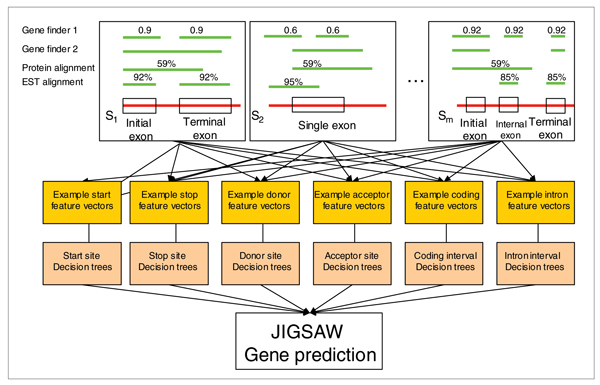
Training procedures for building JIGSAW prediction models. Feature vectors are collected from m examples and separated according to each of the six gene feature types. Decision trees are induced for each of the separated training sets, and their output is combined during the prediction procedure.